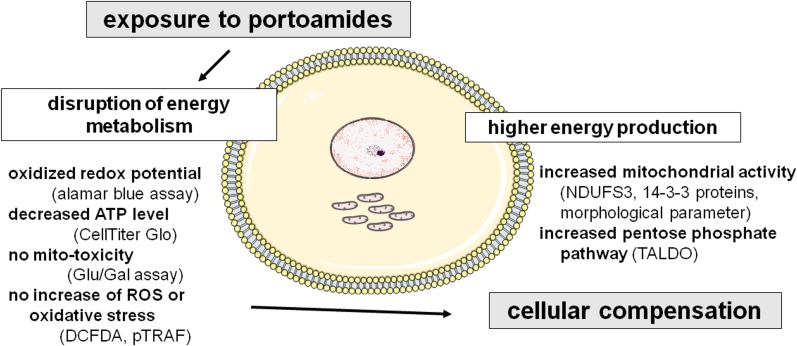
Predicted mechanism of action of portoamides in HT-29 colon adenocarcinoma cells, based on all experimental data.